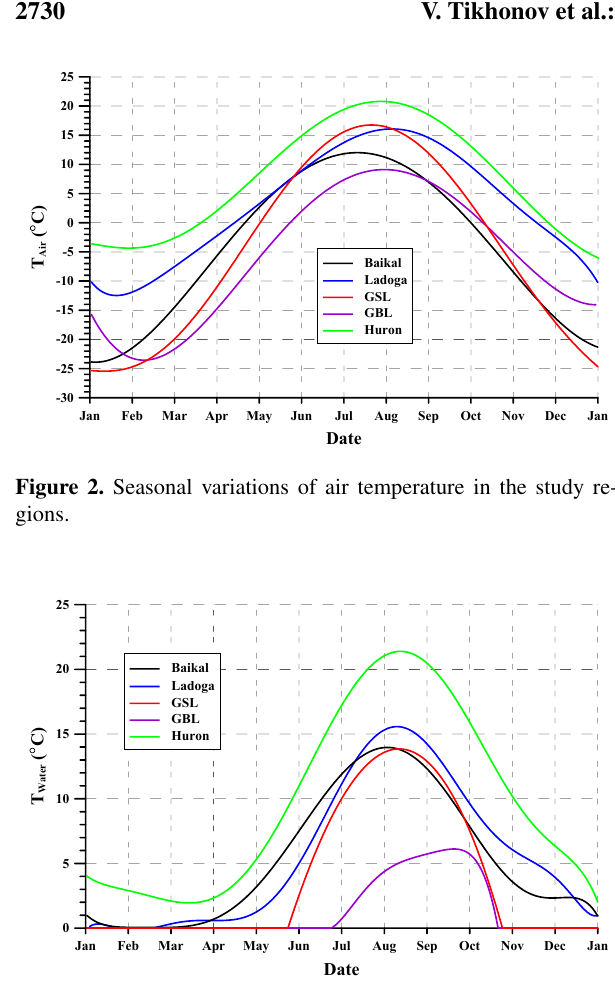
Figure 3. Seasonal variations of water surface temperature in the central parts of the study lakes.